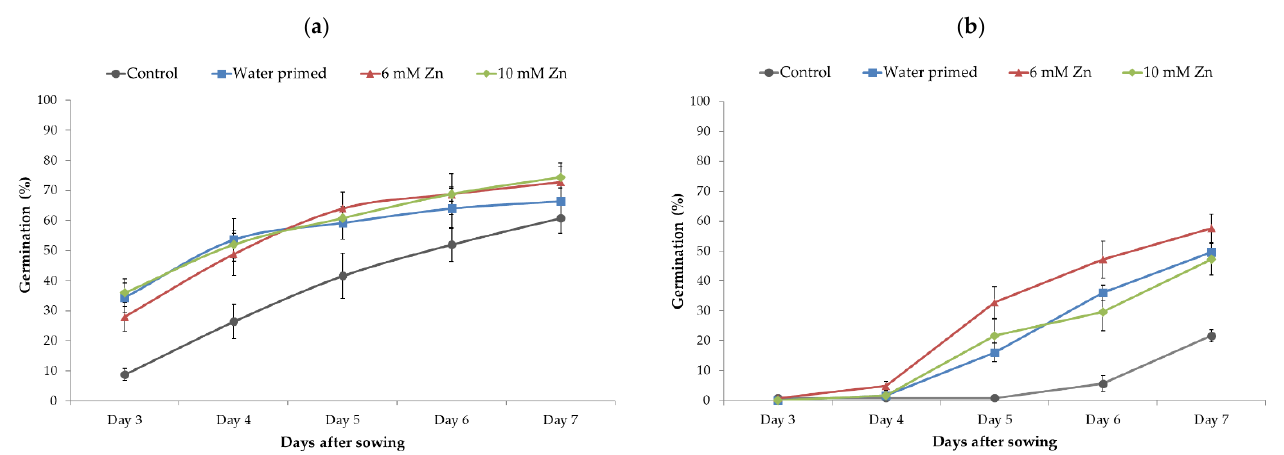
8 of 13 Figure 5. Confocal laser-scanning microscope images of spinach roots of ( a ) control (unprimed) seedlings, ( b ) water- primed seedlings, ( d , e ) 6 mM and 10 mM Zn-primed seedlings, respectively, and ( c , f ) seedlings treated with 200 µM N,N,N’,N-tetrakis (2-pyridylmethyl) ethylenediamine (TPEN) for 30 min and then exposed to 15 µM Zinpyr-1 for 5 h. 3.5. Seed Germination at 15 °C and 8 °C Spinach seeds started germination 3 days after sowing. Figure 6a,b represents seed